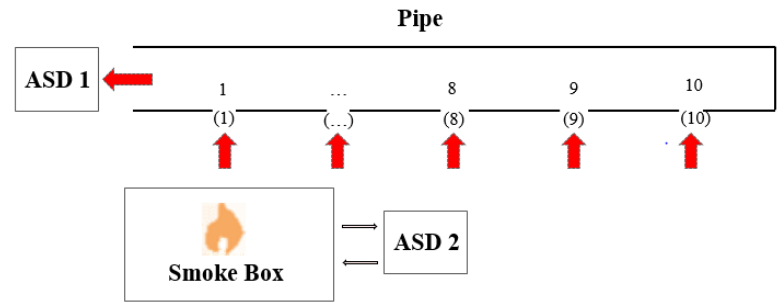
Figure 2. The aspiration smoke detection system with the smokebox and straight pipe.